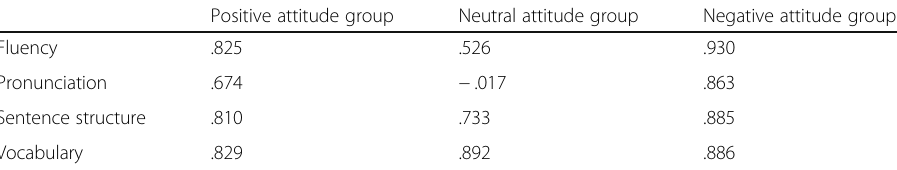
Table 1 Inter-rater